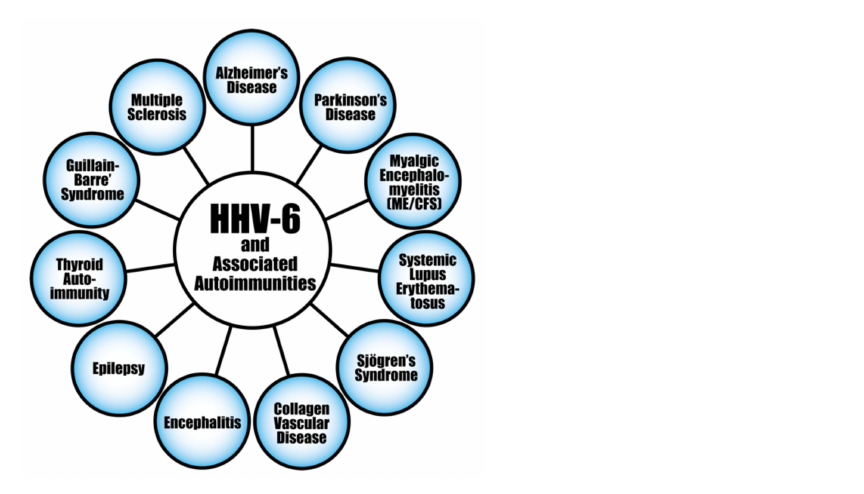
Figure 9. HHV-6 and a few of its associated autoimmune diseases. Finally, viral infection or reactivation with EBV, HHV-6, and other herpesviruses in the CNS can breach the blood-brain barriers, recruiting virus-specific and autoaggressive Th1 and Th17 cells to cause serious damage to neurons [176] (see Figure 10). (1) Herpesviruses enter and infect the body. (2) This causes the activation of T cells and myeloid cells. (3) The activated T cells and myeloid cells penetrate the BBB, which can be weakened by a number of different factors or situations. (4) These cells release IL-1 β cytokines, which activate gamma-delta ( γδ ) T cells. (5) The γδ cells release IL-17, IL-21, and TNF- α , which further acti- vate Th1 and Th17 cells. (6) Activated Th1 cells release IFN- γ and granulocyte-macrophage colony-stimulating factor (GM-CSF), which activates microglia. (7) Activated Th17 cells release IL-17, IFN- γ and TNF- α . (8) The activated Th1 and Th17 cells expand, clone them- selves and multiply, and release inflammatory mediators. (9) The released inflammatory mediators, cytotoxic products, and proteases lead to the destruction of neurons’ myelin sheath and oligodendrocytes. (10) This leads to the production of antibodies against myelin basic protein (MBP), myelin oligodendrocyte glycoprotein (MOG), and other neuronal antigens.